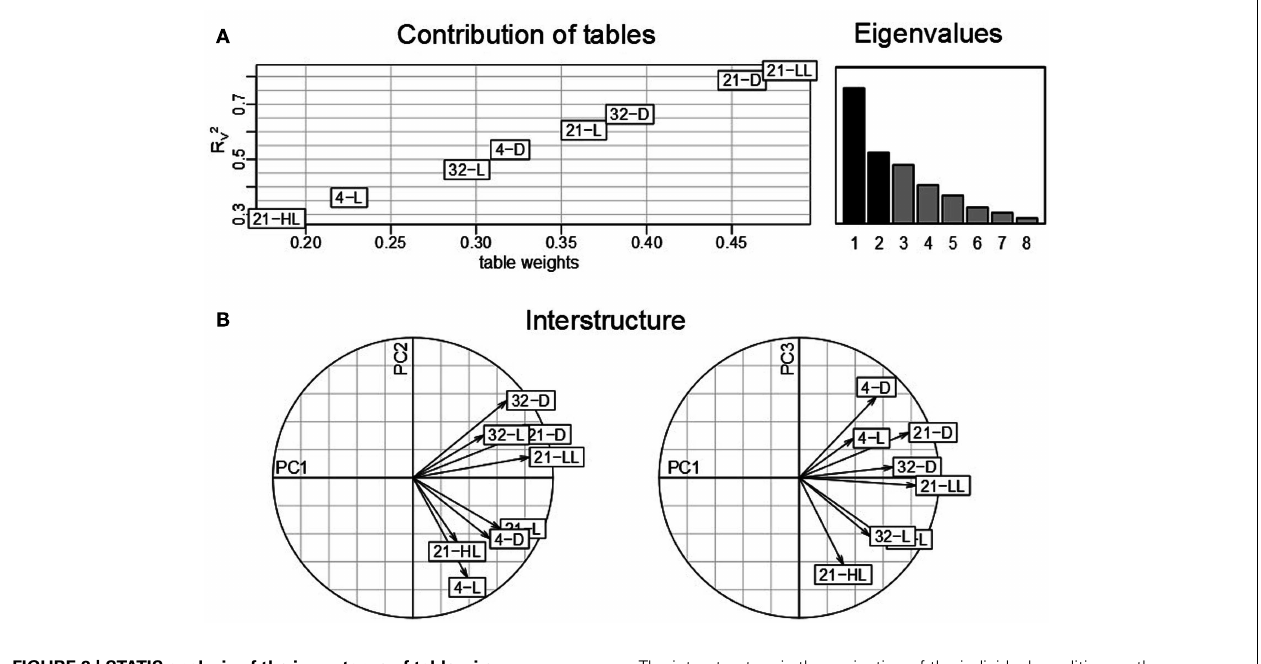
FIGURE 2 | STATIS analysis of the importance of tables, i.e., conditions. (A) Table weights and R V coefficient allow assessing the influence of tables on the resulting compromise; the eigenvalues correspond to the variance captured by the principal components. (B)